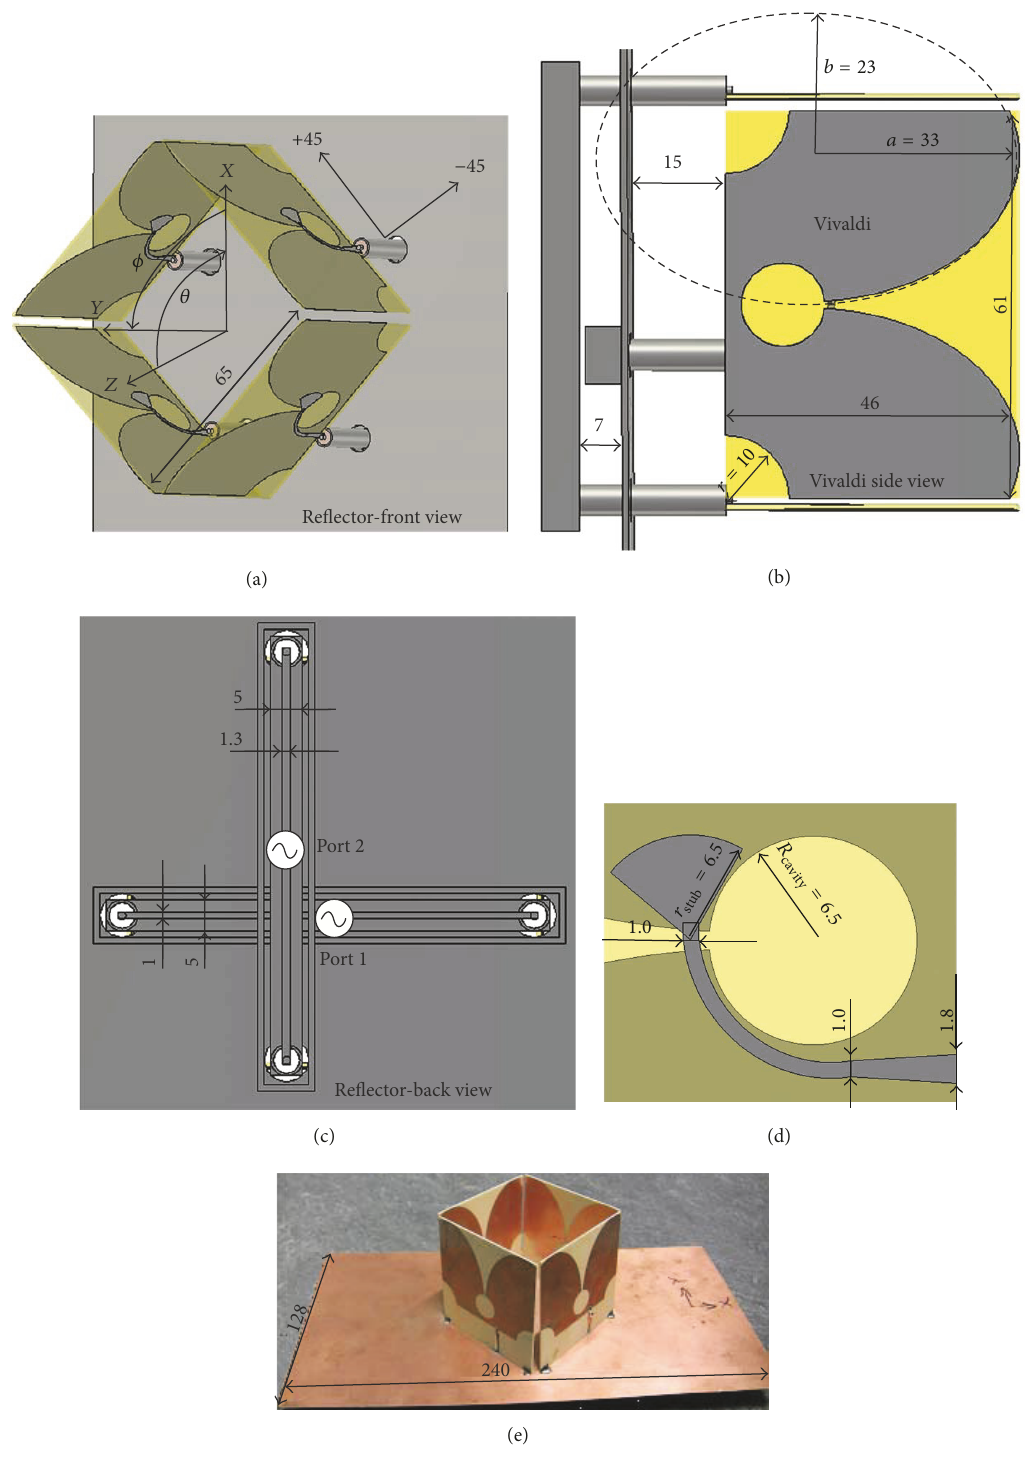
Figure 1: The simulation model of one radiator. (a) Dual polarized radiator structure with the coordinate system (b) and radiator structure with dimensions. The figure is presented in 𝑋𝑍 -cut with respect to 𝜙 = 45 ∘ in 𝑋𝑌 -cut. (c) The symmetrical feed network to divide the signal of one polarization. The figure is presented in 𝑋𝑌 -cut with respect to 𝜙 = 45 ∘ . (d) Microstripline feed with the stub and the cavity dimensions and (e) the prototype antenna. Dimensions are in mm and all the figures are not in the same